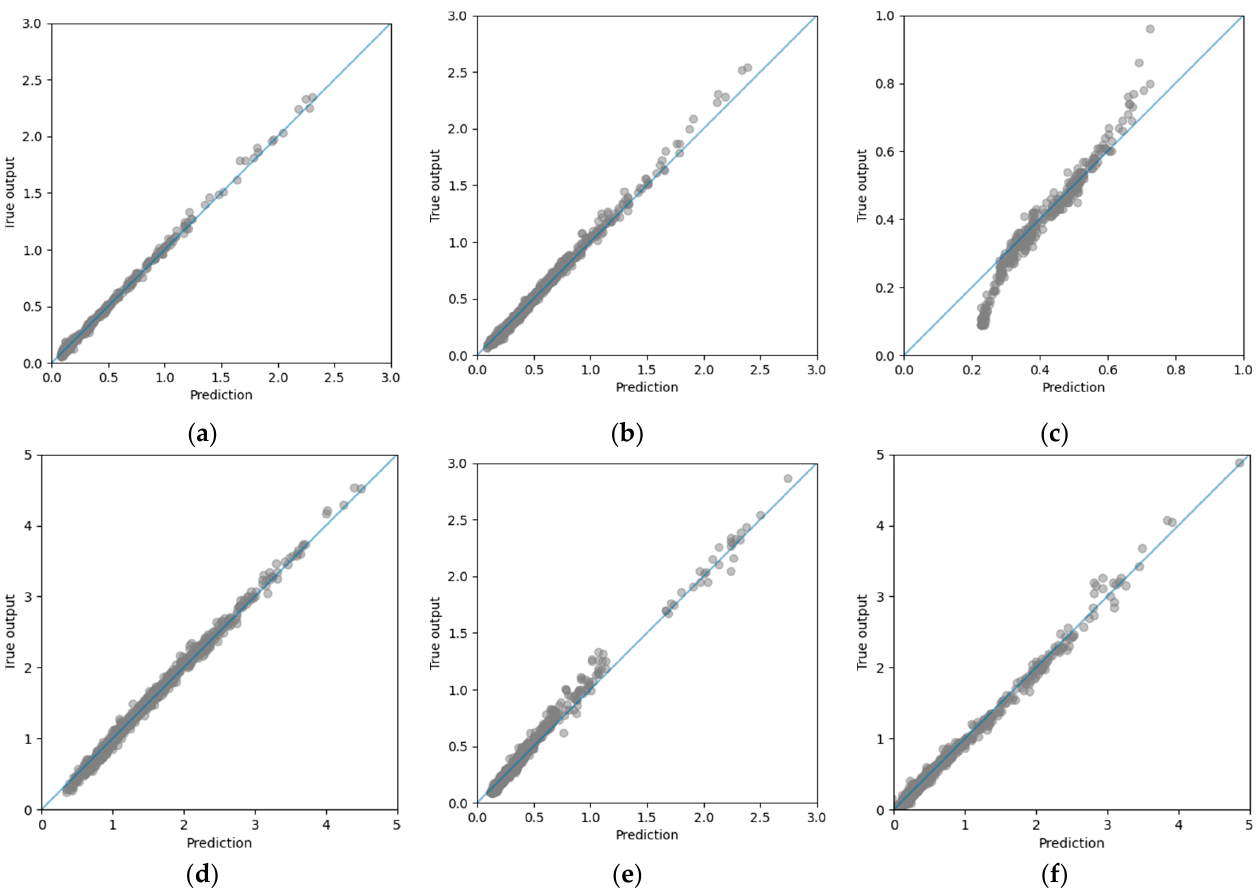
Figure 6. Training error for ( a ) surge, ( b ) sway, ( c ) heave, ( d ) roll, ( e ) pitch and ( f ) yaw ANN models.